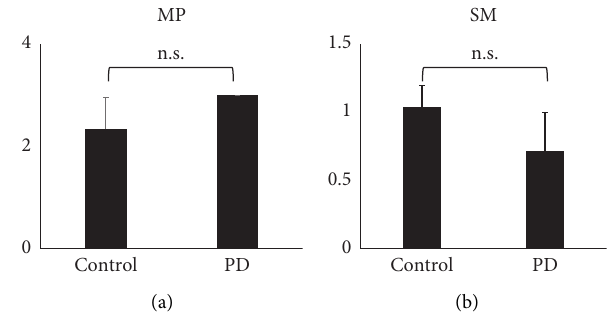
Figure 3: Scores of α Syn expression. In both the (a) muscularis propria (MP) and (b) submucosa (SM), there was no statistically significant difference in α Syn-expression scores between the control and PD groups. Data are shown as mean ± SEM. n.s, not